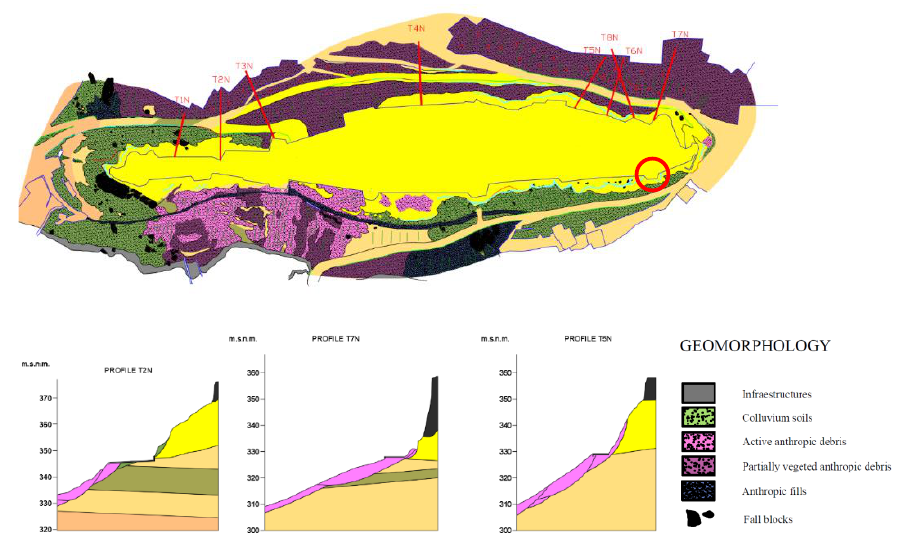
Figure 16. Geomorphological map of the castle area and several examples of geological – geomor- phological profiles. The red circle indicates the location of the tower.